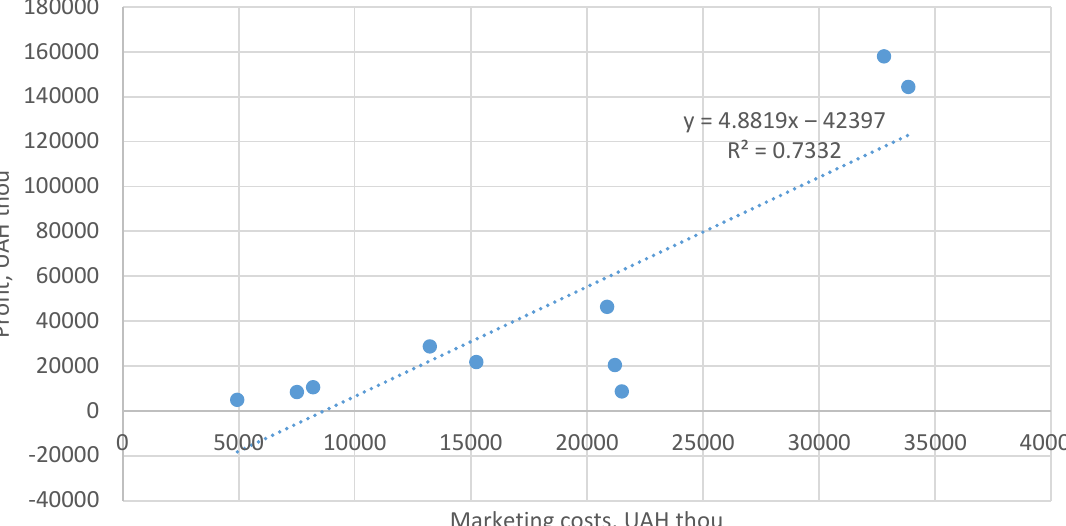
Figure 2. Correlation-regression dependence between the volume of marketing expenses and the profit margin of agricultural enterprises in Khrystynivka district, Cherkasy region (according to 2007–2016 data)